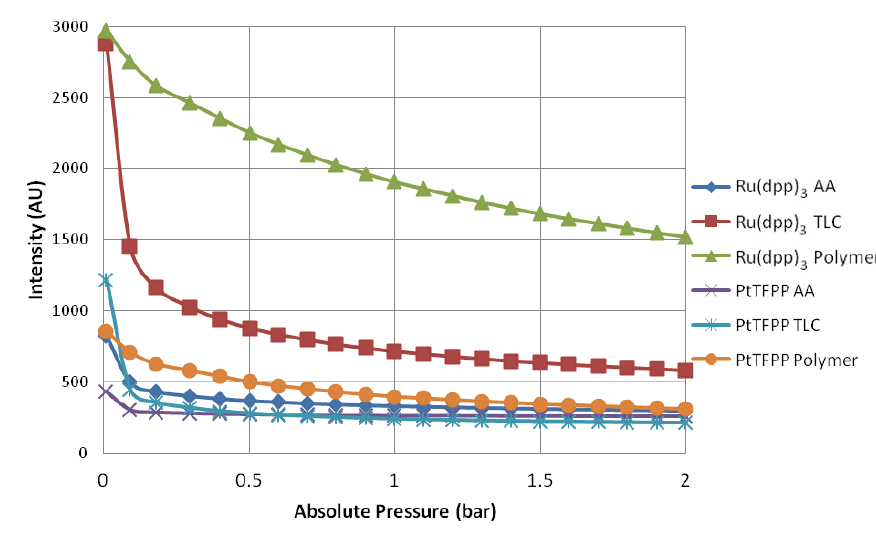
Figure 5. Intensity Output vs. Pressure.